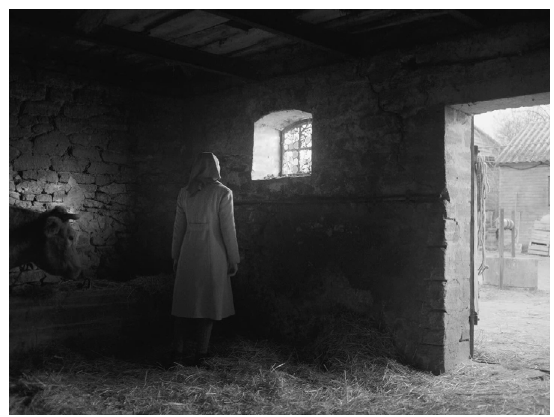
Figure 2 . Ida at her mother’s window. Figure 3. The light of the window on Ida.